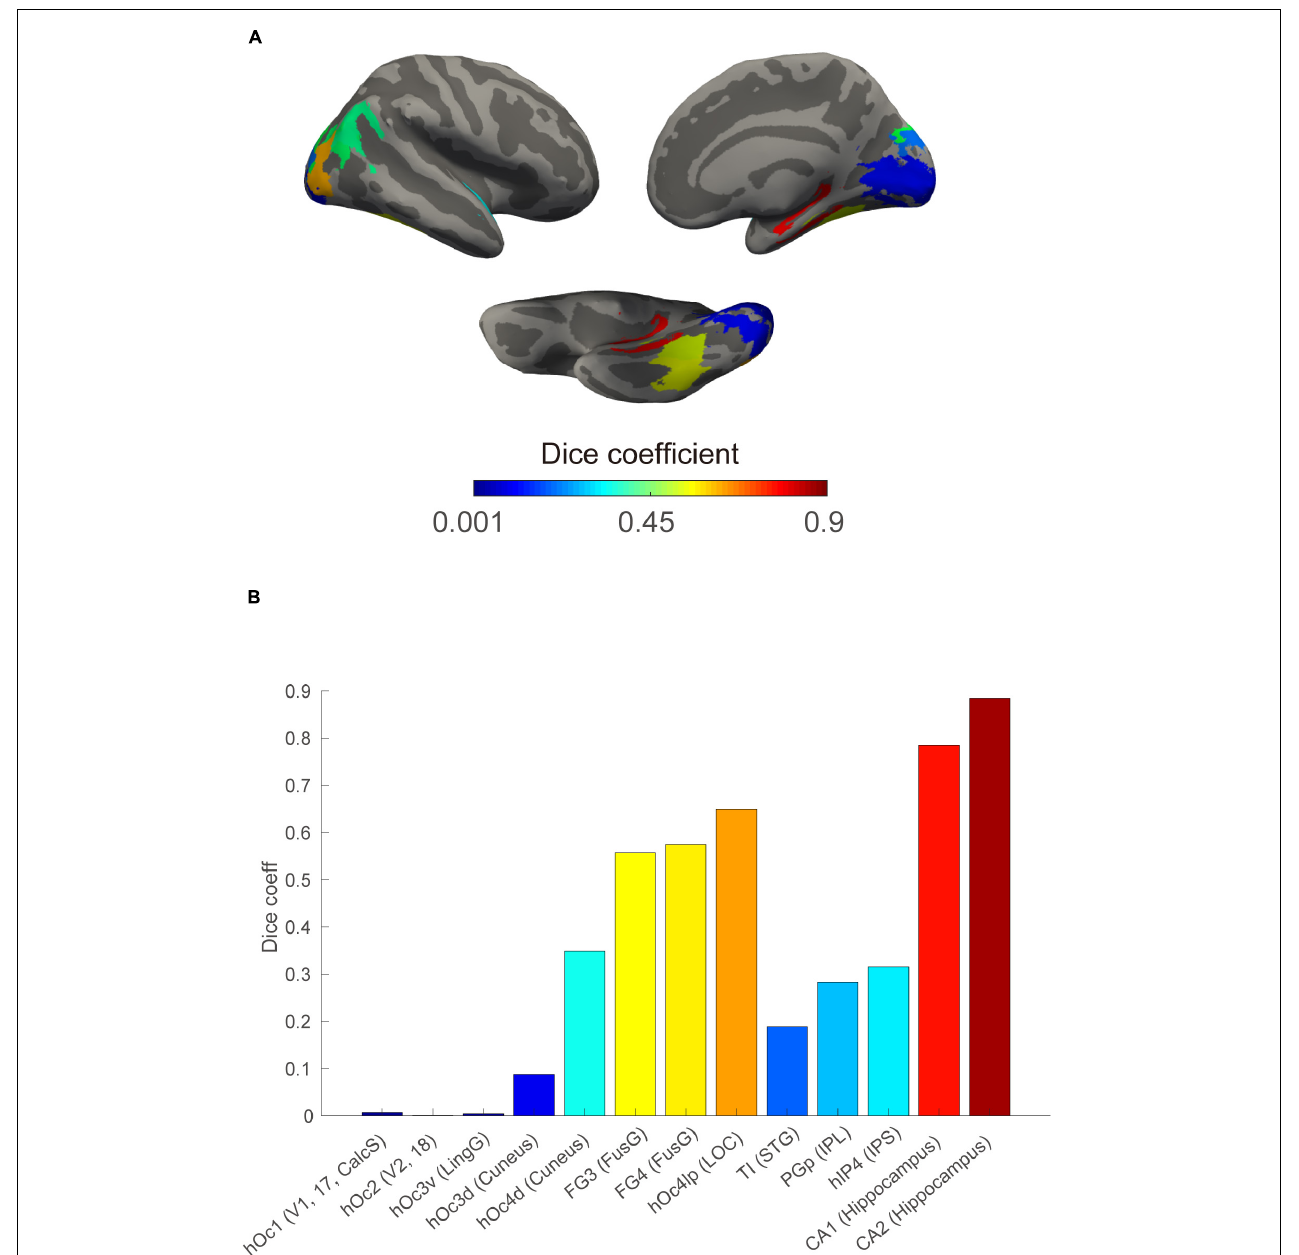
FIGURE 4 | Increased spatial overlap between internal and external visual sensations in regions along the visual processing stream. (A) Spatial Dice coefficient between the internal and external visual sensations at the ROI level rendered on the cortical surface based on a public cytoarchitecture atlas. (B) ROI-based Dice coefficient along visual information processing stream defined generally. Bars indicate the extent of spatial overlap, displayed using the corresponding ROIs color on the above surface. CalcS, calcarine sulcus; FusG, fusiform gyrus; IPL, inferior parietal lobule; IPS, intra-parietal sulcus; LingG, lingual gyrus; LOC, lateral occipital cortex; and STG, superior temporal